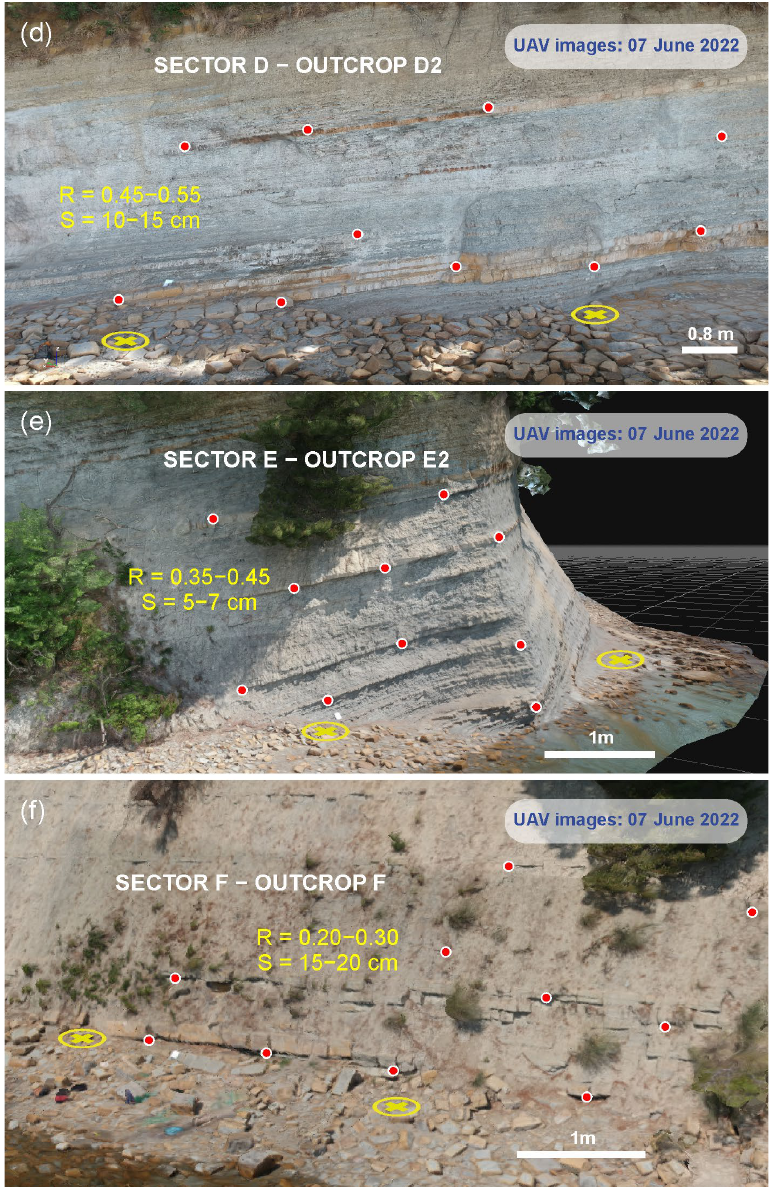
Figure 9. ( a – f ). 3D surface models (UAV images) of three sectors along the Flysch Sea cliff at Debeli Rtič. The location of the GCPs used for the point cloud georeferencing (yellow encircled crosses) and for the photogrammetric bundle adjustment (red dots) are shown. Numerical values represent the sandstone/marl ratio (R) and the average thickness of the sandstone layers (S). Table 6. Number of points forming the clouds and 3D models reconstructed using UAV images. Outcrop Sparse Point Cloud